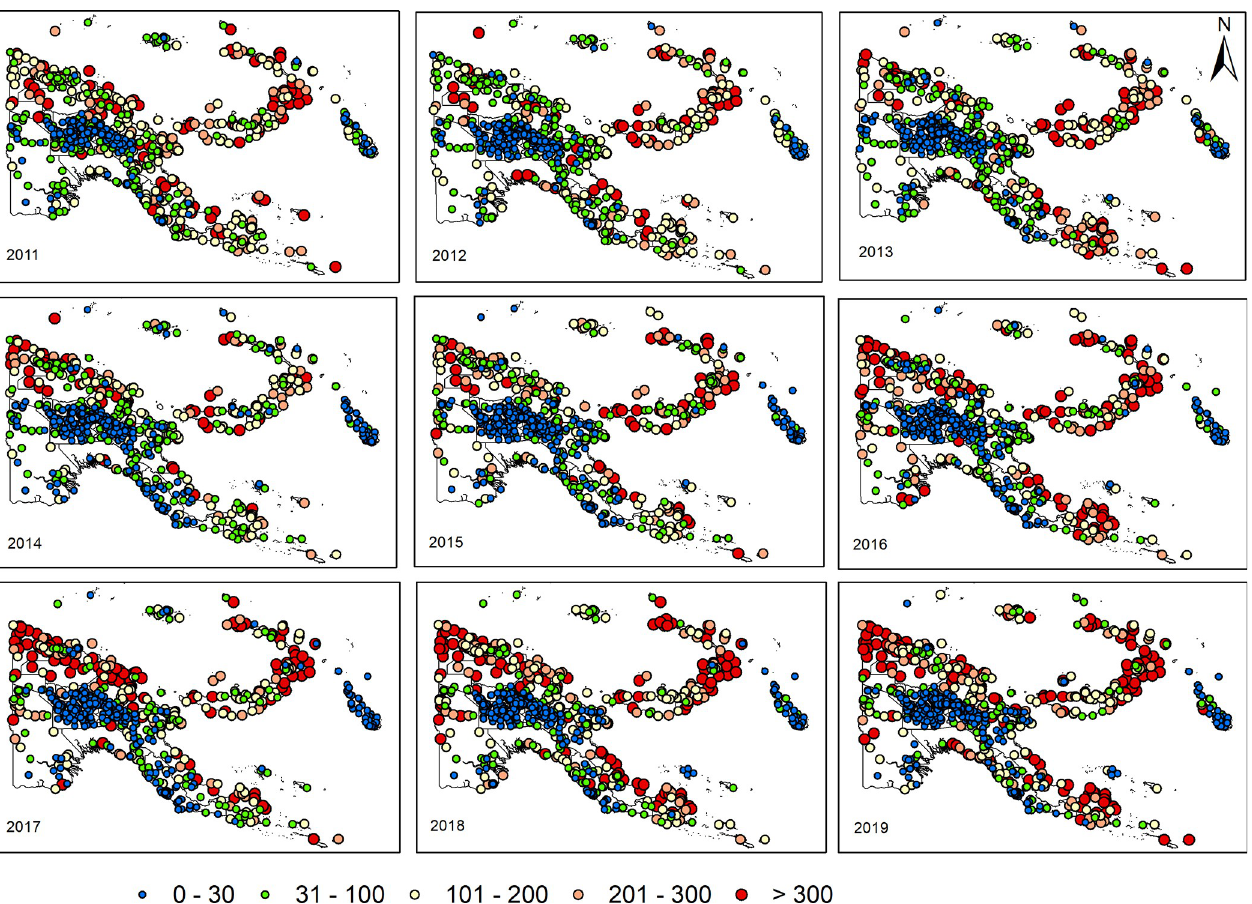
Fig 7. Yearly maps of annual malaria incidence in catchment areas of 806 health facilities, PNG (2011–2019). Five categories of incidence per 1000: > 300 (red), 300–200 (pink), 200–100 (yellow), 100–30 (green), and < 30 (blue). Incidence was calculated as annual sum of adjusted presumptive and confirmed (positive microscopy or mRDTs) malaria cases and estimates of patients unseeking care, among the catchment’s population. Source of the map base layer: WFP-World Food Programme, 2019. Map created by the authors using a licensed ArcGIS Desktop 10.5 software from Esri (http://www.arcgis.com/).